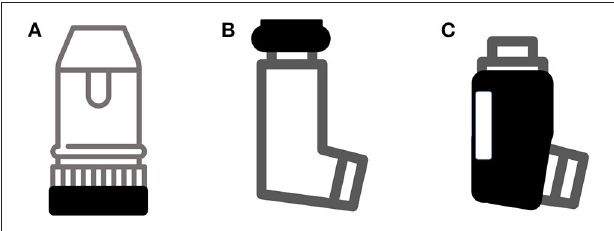
FIGURE 2 | Common types of add-on devices to create smart inhalers. (A) Detection of device priming; (B) Detection of patient actuating device; (C) Jacket to detect airflow. Not shown are devices such as INhaler Compliance Assessment (INCA) that detect actuation and technique purely